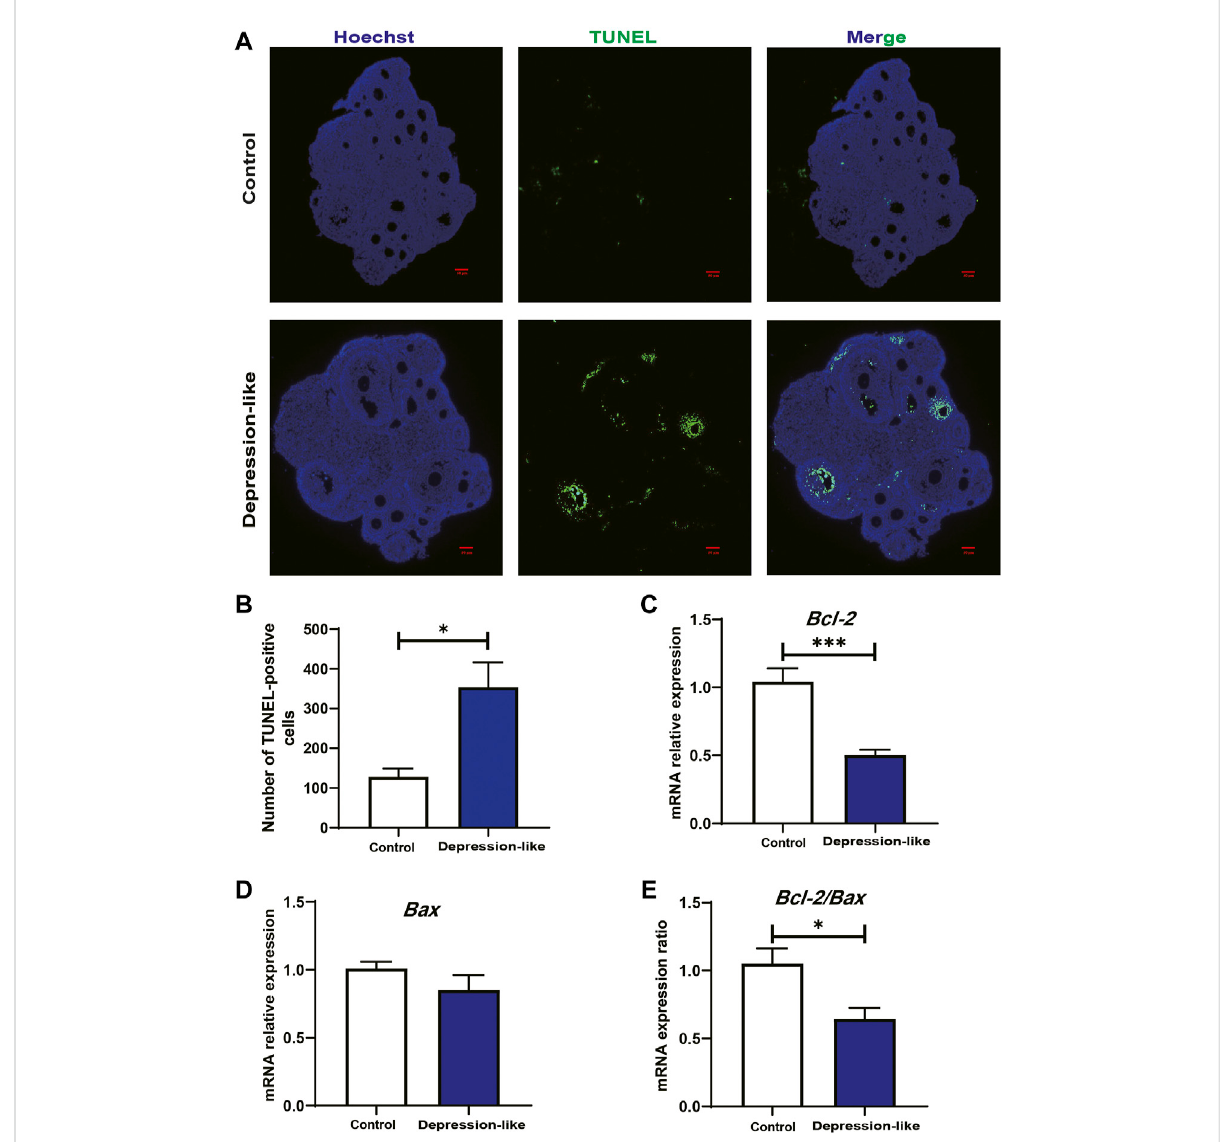
FIGURE 3 TUNEL staining of the ovarian section and relative mRNA levels of Bcl2 and Bax in granulosa cells ’ follicle development. (A) TUNEL assay showing the apoptosis of granulosa cells and atresia of follicles in control and depression-like ovarian tissues. Four mice in each group were detected. Green, TUNEL; blue, Hoechst. Scale bars, 50 μ m. (B) Quantitative analysis of TUNEL-positive assays in the ovaries of the depression-like mice compared with control. (C , D) Relative mRNA levels of Bcl-2 and Bax were performed by real-time PCR in GCs isolated from control and depression-like mice. (E) Quanti fi cation of mRNA levels of Bcl-2/Bax (** p < 0.01; * p <